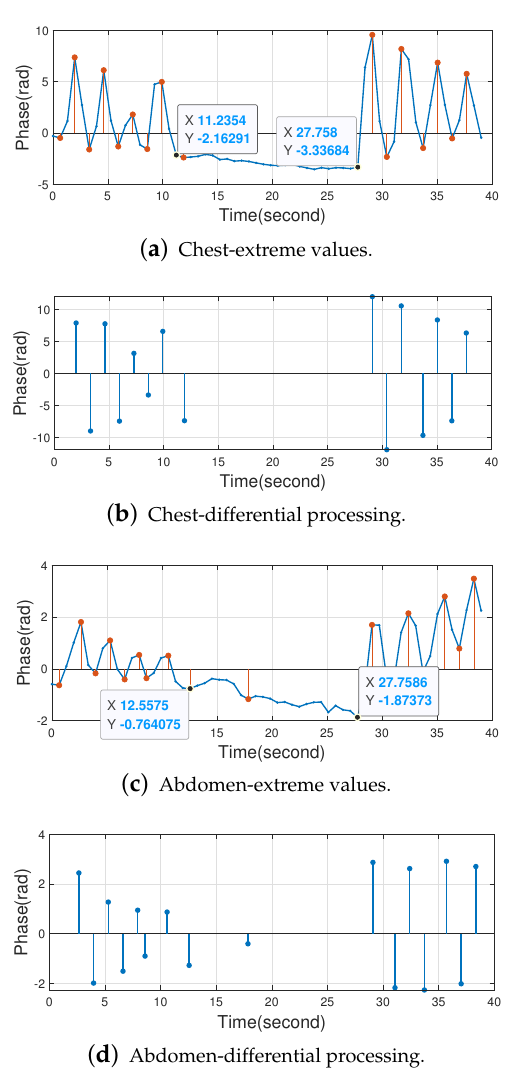
Figure 21. Apnea monitoring without Butterworth bandpass